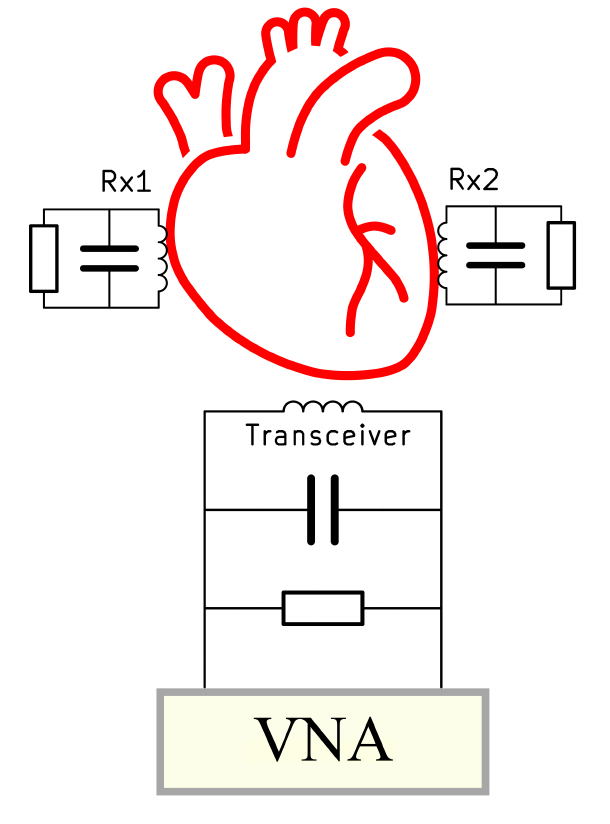
Figure 1. A schematic diagram representing the placement of the coils in and above the